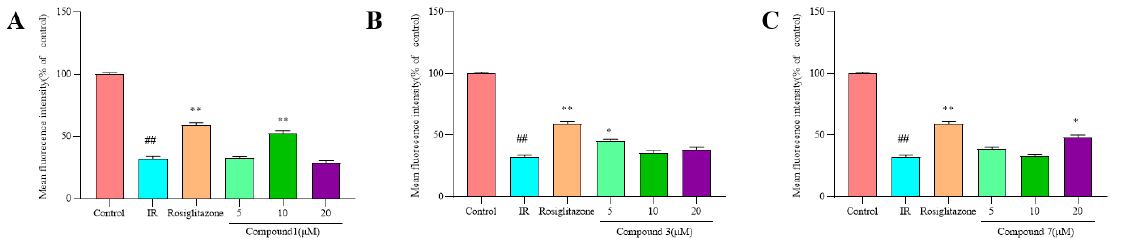
Figure 7. Effect of compounds 1 , 3 and 7 on glucose uptake in insulin-induced HepG2 cells ( x ± s, n = 4). ( A ) Compound 1 corresponding histograms of the mean fluorescence intensity of 2-NBDG; ( B ) Compound 3 corresponding histograms of the mean fluorescence intensity of 2-NBDG; ( C ) Compound 7 corresponding histograms of the mean fluorescence intensity of 2-NBDG. ## p < 0.01, versus control group; * p < 0.05 or ** p < 0.01, versus insulin